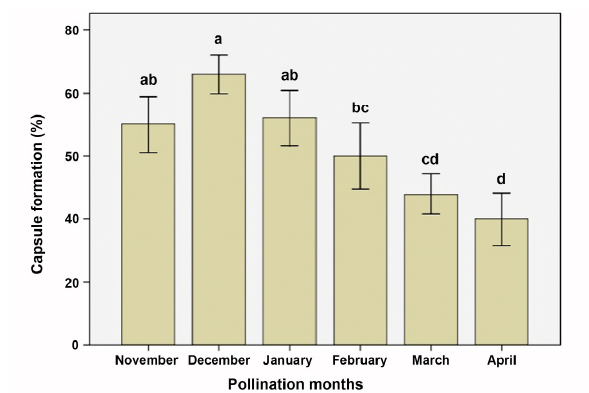
Fig. 2. Influence of pollination time on post-pollination capsules formation frequency (%) Data signify (mean±standard error bar) 5 flowers per treatment in 10 replicated experiments. Mean column with the same letter are not significant at P ≤ 0.05 based on one-way analysis of variance (ANOVA) followed by Tukey’s test. Data expressed as percentage were transformed using arcsine prior to ANOVA and converted back to the original scale for demonstration in the histobar (Compton, 1994).